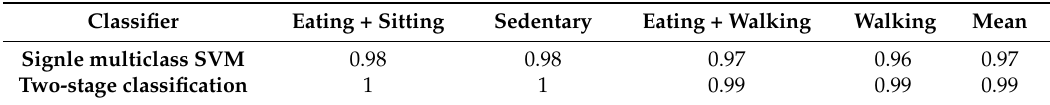
Figure 5. Receiver Operation Characteristics (ROC) Curves for two classification approaches. ( a ) ROC curves for different classes when single linear SVM model is trained; ( b ) ROC curve for two-stage classification. The first stage uses two linear SVM models for detection of food intake and walking, after which a simple decision tree is used to predict the final output class. Table 5. The area under the Curve (AUC) for each class. Mean AUC for each classifier was computed as the average of AUCs for all classes (Mean